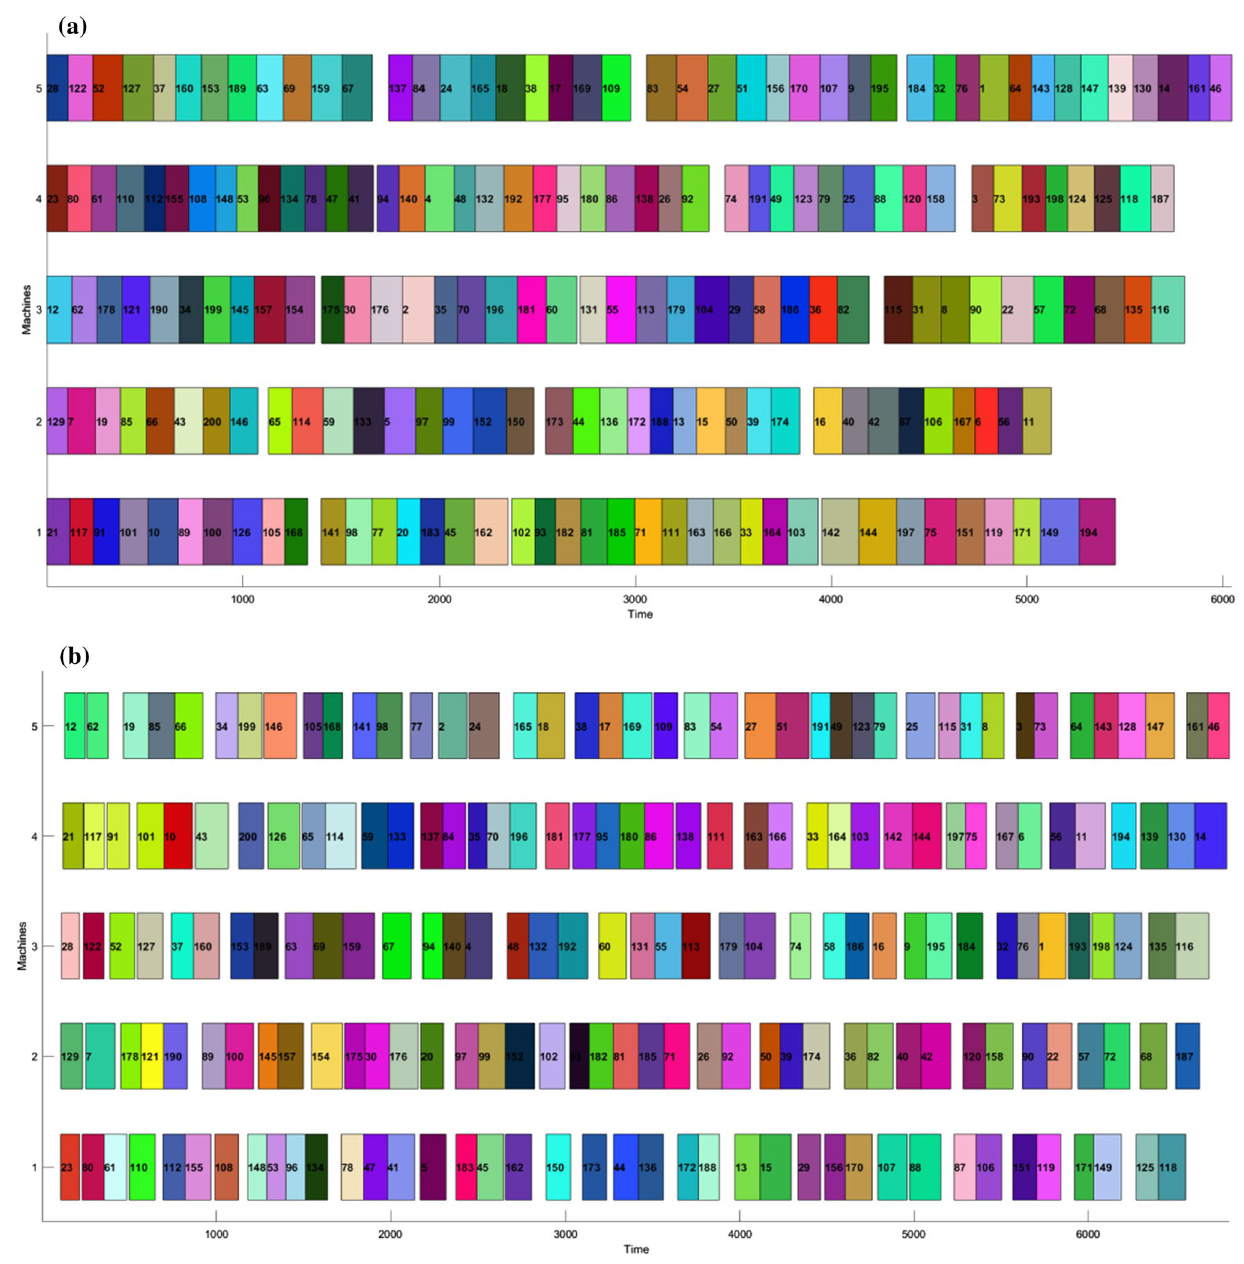
Fig. 9 The Gantt chart of the solution of NSGA-II-GT. a , b correspond to the Gantt chart of the first stage and the second stage,